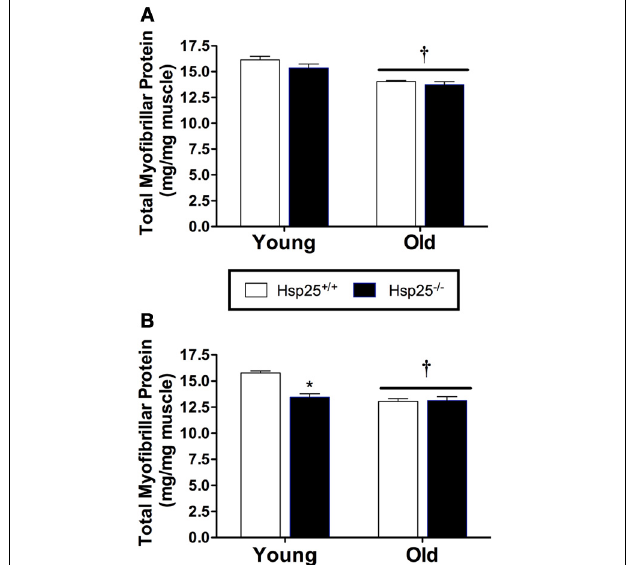
FIGURE 4 | Average gastrocnemius total myofibrillar protein levels in young and old Hsp 25 + / + and Hsp 25 − / − mice following muscle contractile measurements (A) or 2 weeks of running wheel activity (B). ∗ Significantly different from young Hsp 25 + / + ( P < 0 . 0001), † significant